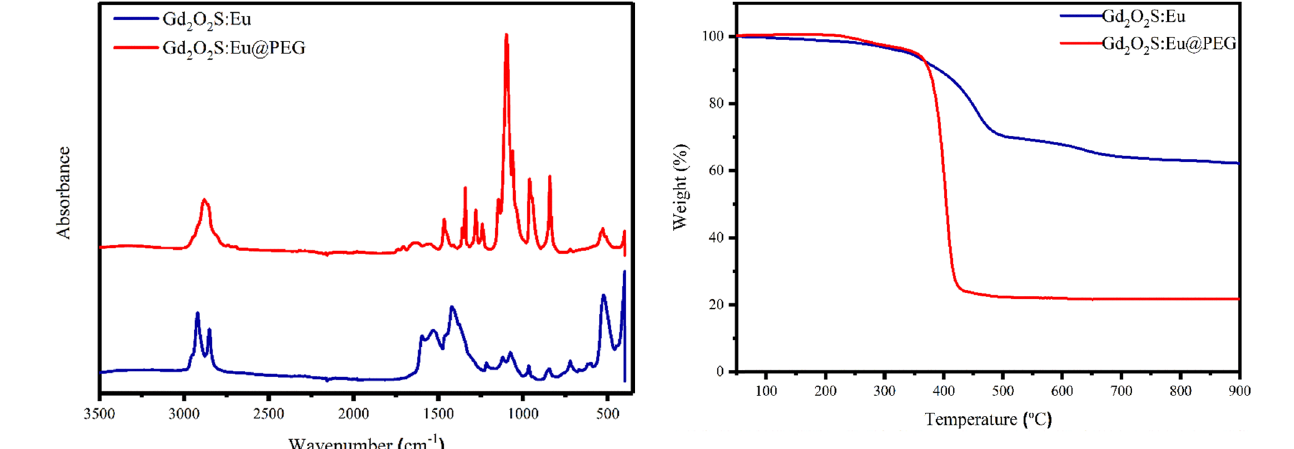
Figure 3: FT - IR spectra of Gd 2 O 2 S:Eu before and after modi fi cation.